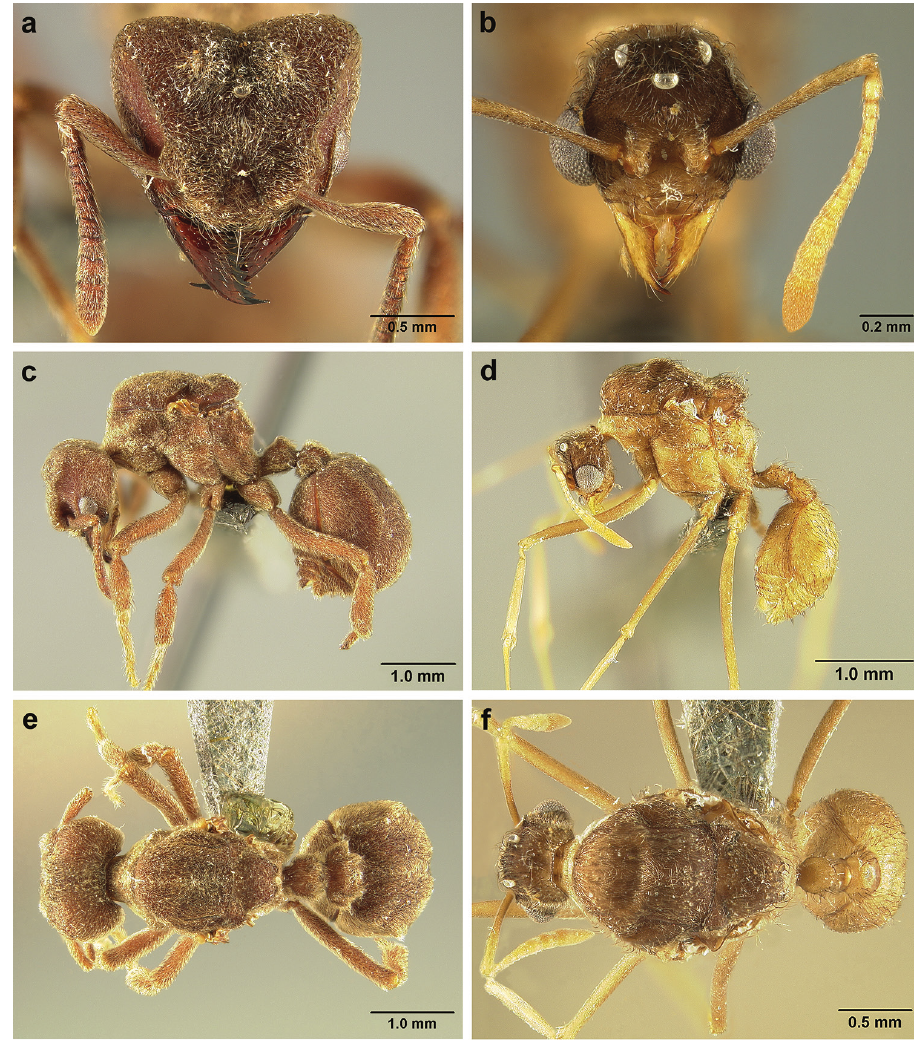
Figure 58. S. saussurei queen and male; head, lateral profile, and dorsal view. Queen (USNMENT01125514) ( a, c, e ) Male (USNMENT01125515) ( b, d, f ).